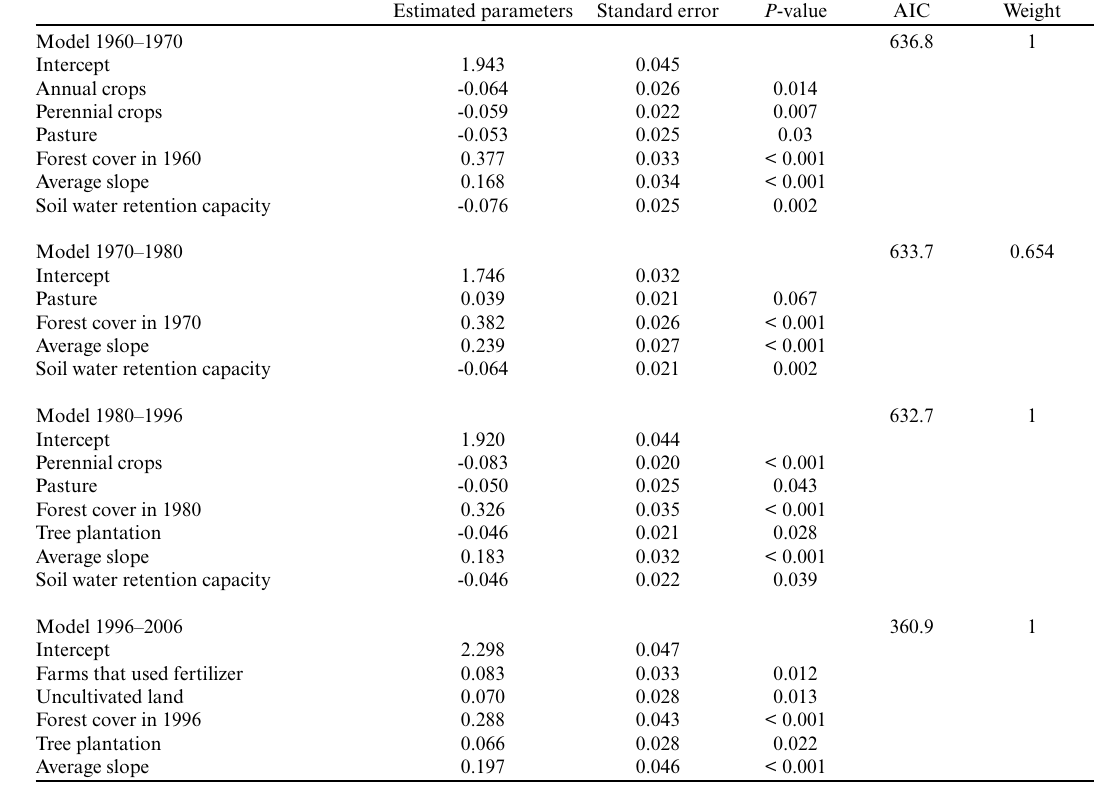
Table 2 . Akaike information criterion (AIC) and weight for selected models for each time periods (1960–1970, 1970–1980, 1980–1996, 1996–2006). Estimated parameters, standard errors, and P -values from the predictors are also provided. All explanatory variables were included in the models as a ratio, except for slope, soil water retention capacity, and percentage of forest cover at the start of the interval.